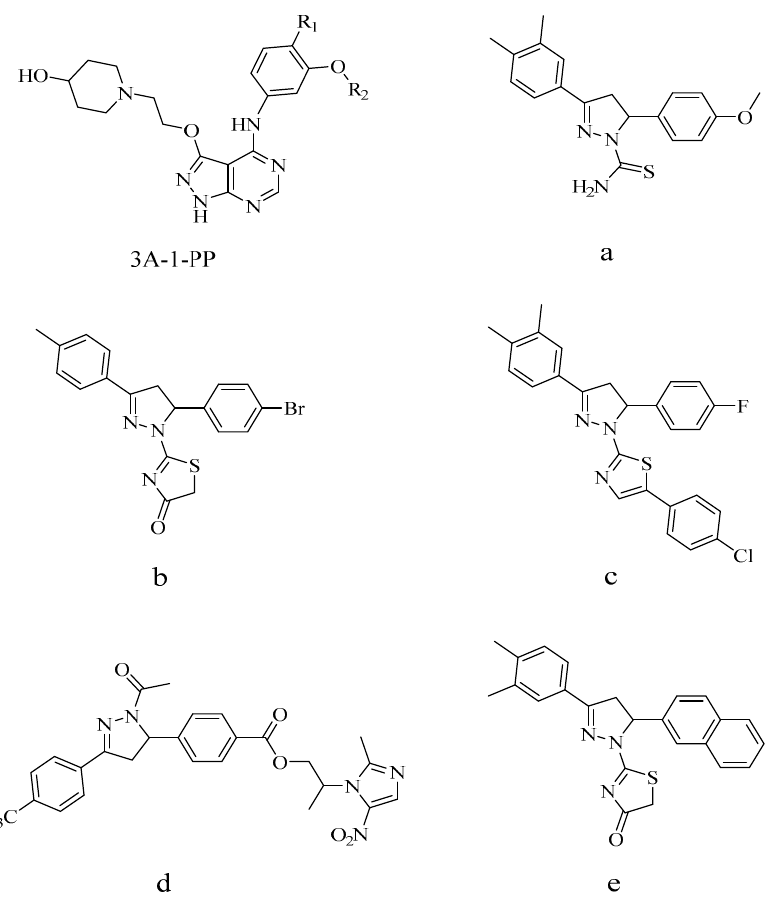
Figure 1. Chemical structures of some reported compounds.